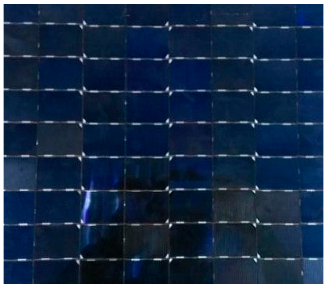
Figure 2. The surface structure of the solar panel.